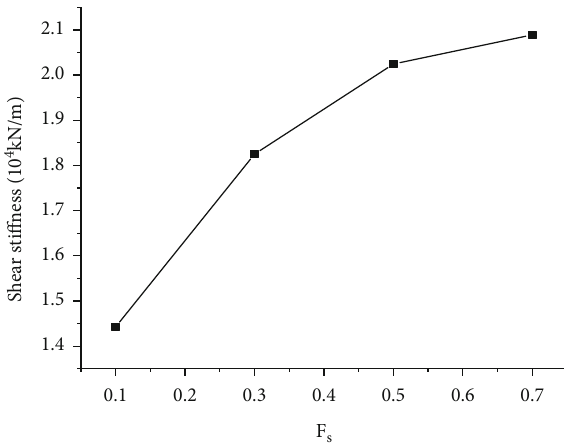
ff s and shear sti